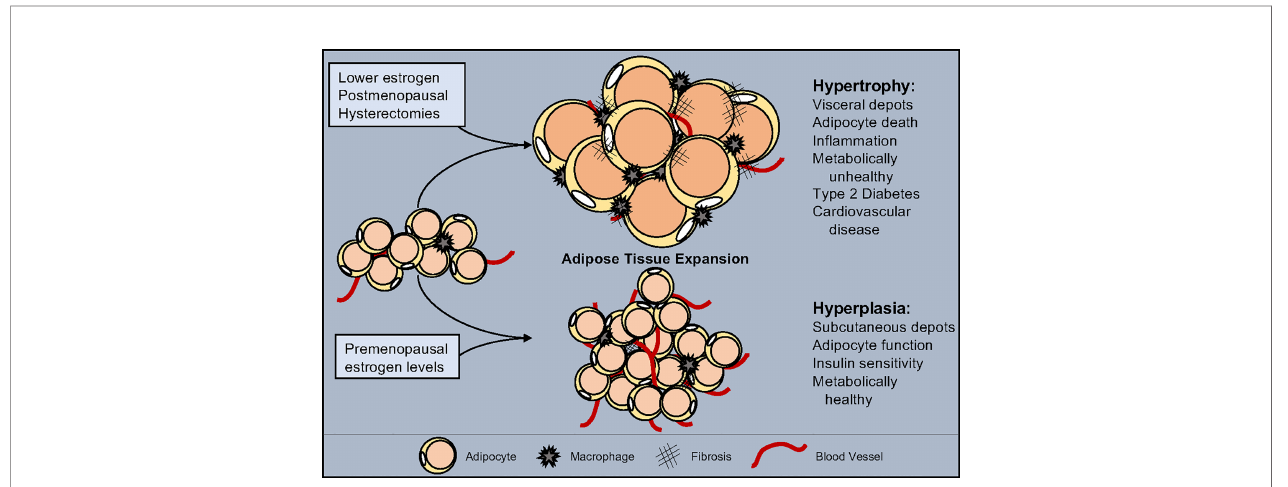
FIGURE 1 | Estrogen in fl uence on adipose tissue expansion. White adipose tissue can expand through either hypertrophy, the swelling of individual adipocytes, or hyperplasia, the increase of adipocyte numbers. Hypertrophy is accompanied by a reduction in vascularization, increased in fl ammation, and promotes fi brosis. Hyperplasia maintains tissue health by facilitating vascularization, promoting anti-in fl ammatory signals and block fi brosis. Estrogen levels play a role in determining the type of expansion and location which shifts as estrogen decreases due to pharmacological drugs, medical procedures, and/or age. While normal estrogen levels result in hyperplastic subcutaneous adipose tissue growth, reduced estrogen leads to metabolically unhealthy hypertrophic visceral adipose tissue